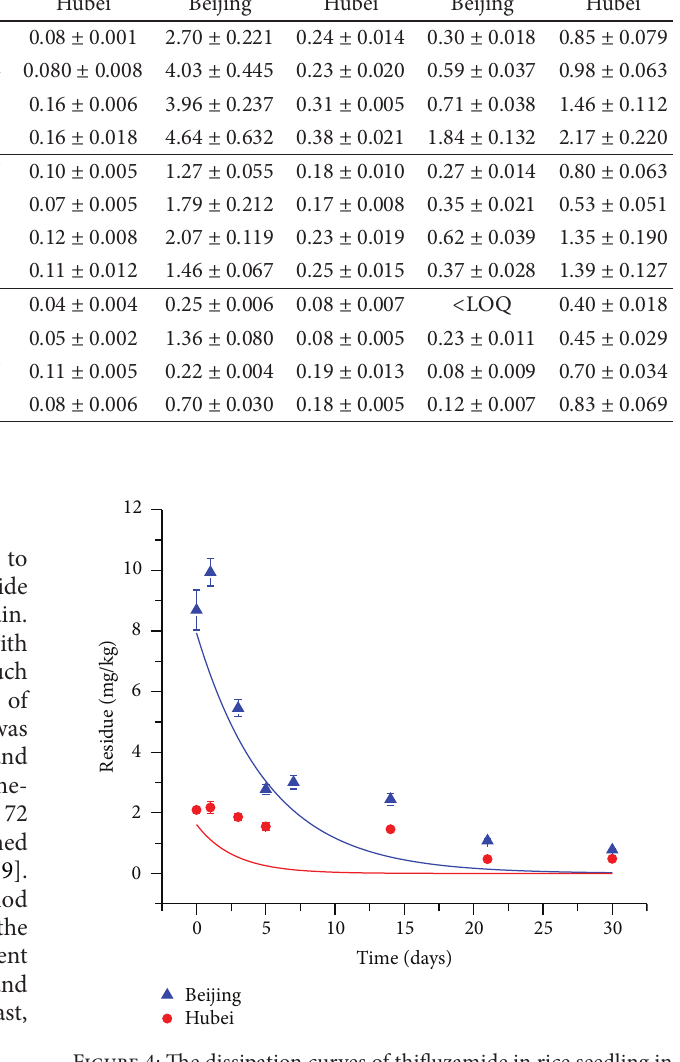
Figure 4: The dissipation curves of thifluzamide in rice seedling in Beijing and Hubei